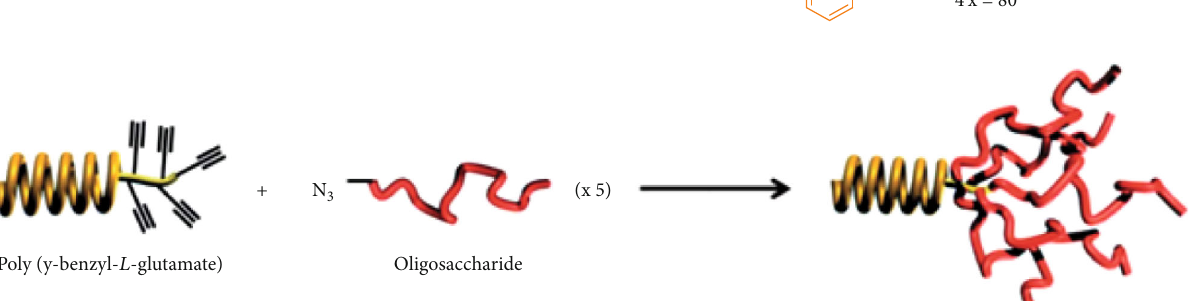
by Lecommandoux et al. 5